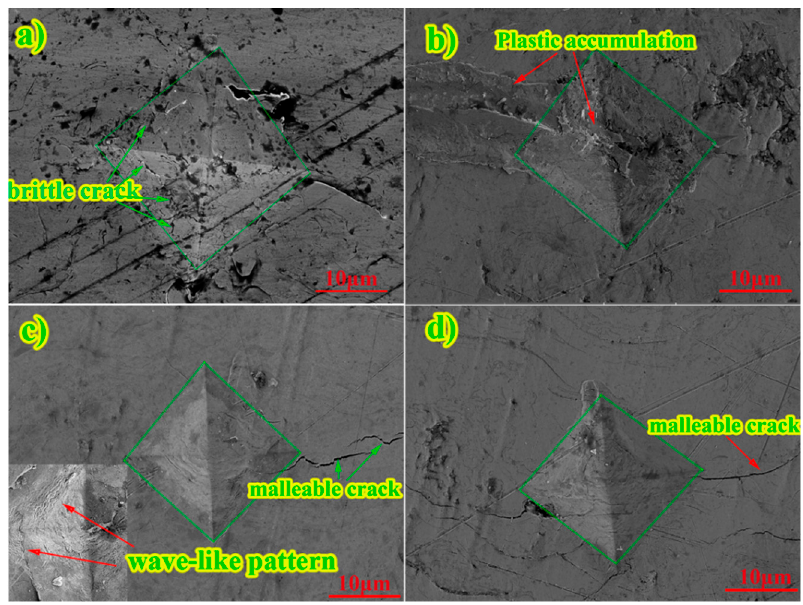
Figure 7. Indentation morphologies of as-sprayed CoMoCrSi coating ( a ) and coating annealed for 3 h ( b ), 5 h ( c ), and 10 h ( d ).